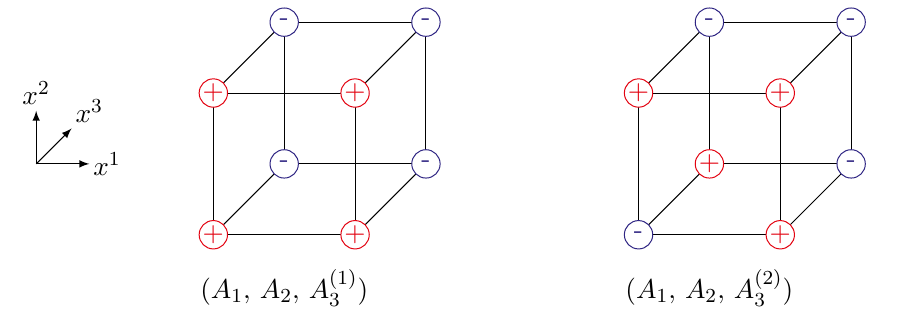
Figure 1 . Inequivalent Type II orientifold configurations on T 3 with coordinates ( x 1 , x 2 , x 3 ) dual to the Spin(32) / Z 2 heterotic string on T 3 with the specified Wilson lines (see eqs. (3.4) and (3.7)). The + sign corresponds to a stack of 4 D 6 -brane pairs on top of an O 6 − -plane. The − sign corresponds to a naked O 6 − -plane. Alternatively, the + signs can be interpreted as O 6 + -planes, leading to rank reduction by 16 in two inequivalent ways. These correspond to inequivalent ways of freezing four D 4 singularities in the M-Theory dual